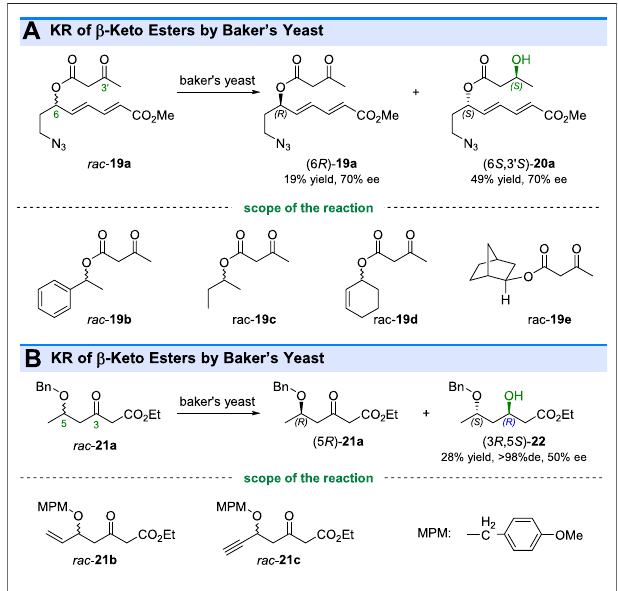
FIGURE 5 | Kinetic resolution of β -keto esters (A,B)